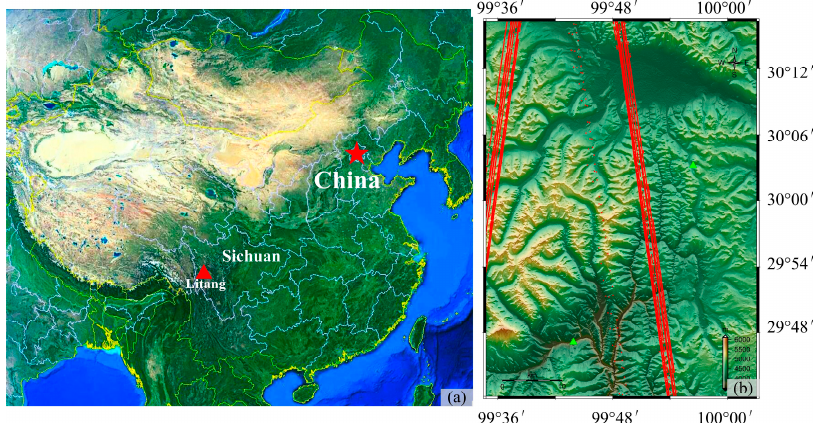
Figure 9. ( a ) Location map of the study area. The red triangle is Litang County, Ganzi Tibetan Autonomous Prefecture, and ( b ) the corresponding SRTM DEM. The red dots are ICESat data and the two green triangles are the ground control points.